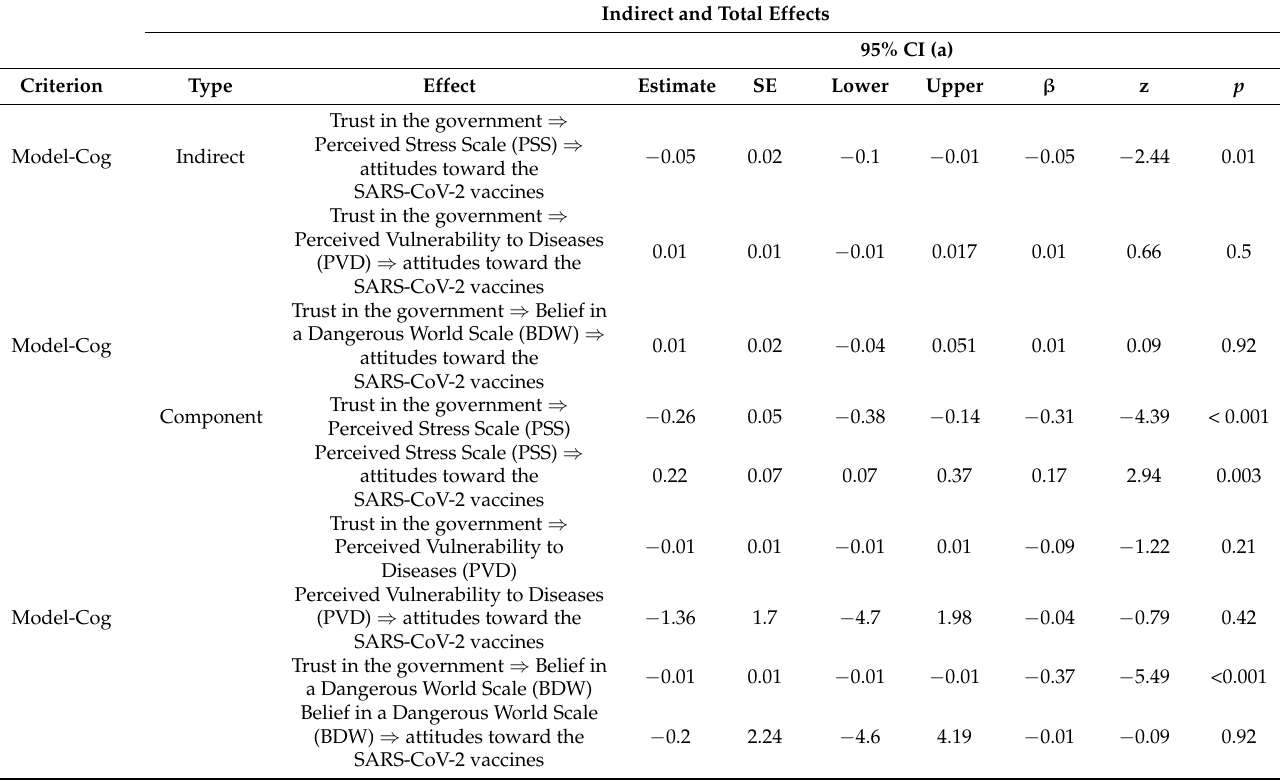
Table 1. Mediation estimates for model-Cog and